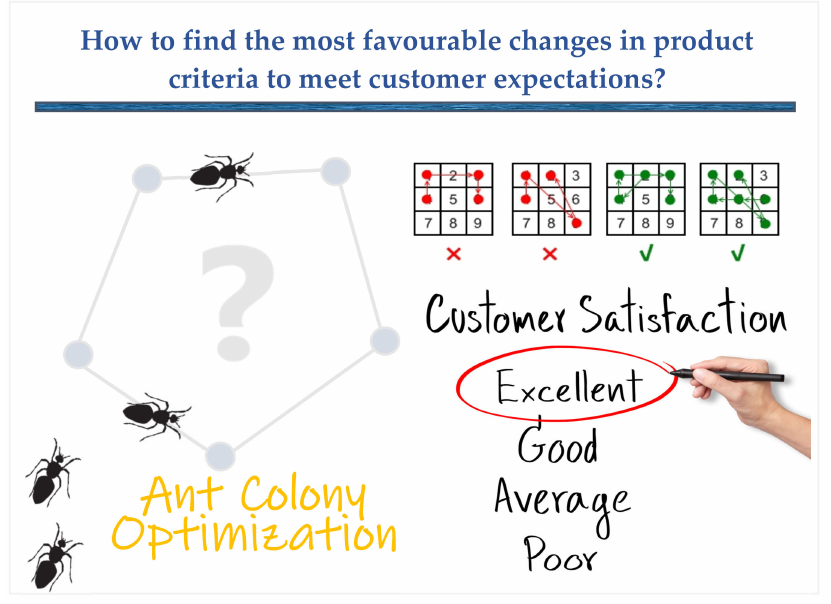
Figure 1. General concept of